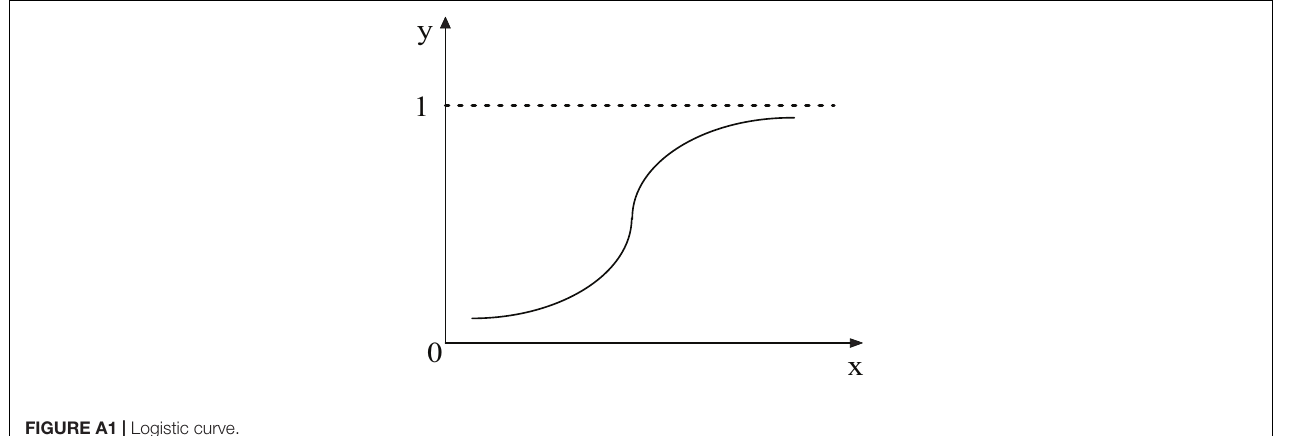
FIGURE A1 | Logistic